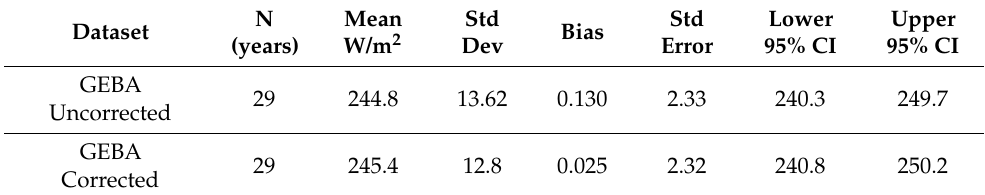
Table 5. Annual shortwave irradiance descriptive statistics of dimming period 1950–1978 with bootstrapping (N = 1000). For the GEBA corrected time series, the lower and upper 95% confidence intervals were 240.8 and 250.2. Only 4% missing months. These were interpolated for an annual